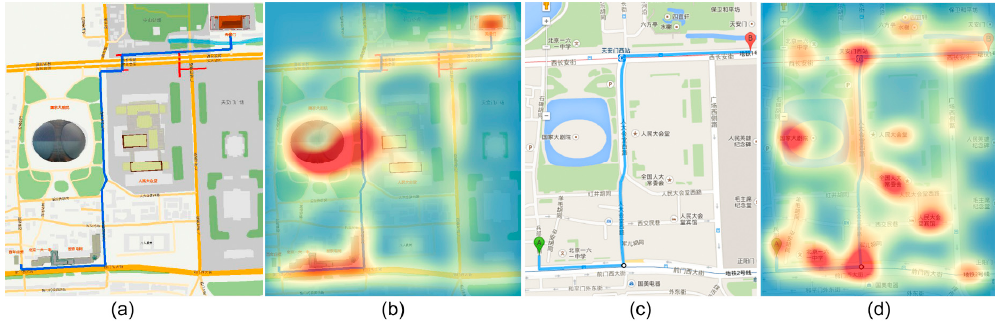
Figure 2. The results of pre-evaluation: ( a ) the designed 3D map; ( b ) saliency map of the 3D map; ( c ) the 2D Google map; and ( d ) saliency map of the 2D map. Darker red means higher saliency, and light green indicates lower saliency. Refer to Figure 1 for English version of Chinese names of landmarks and streets in the map. The blue line indicates the pre-defined route.